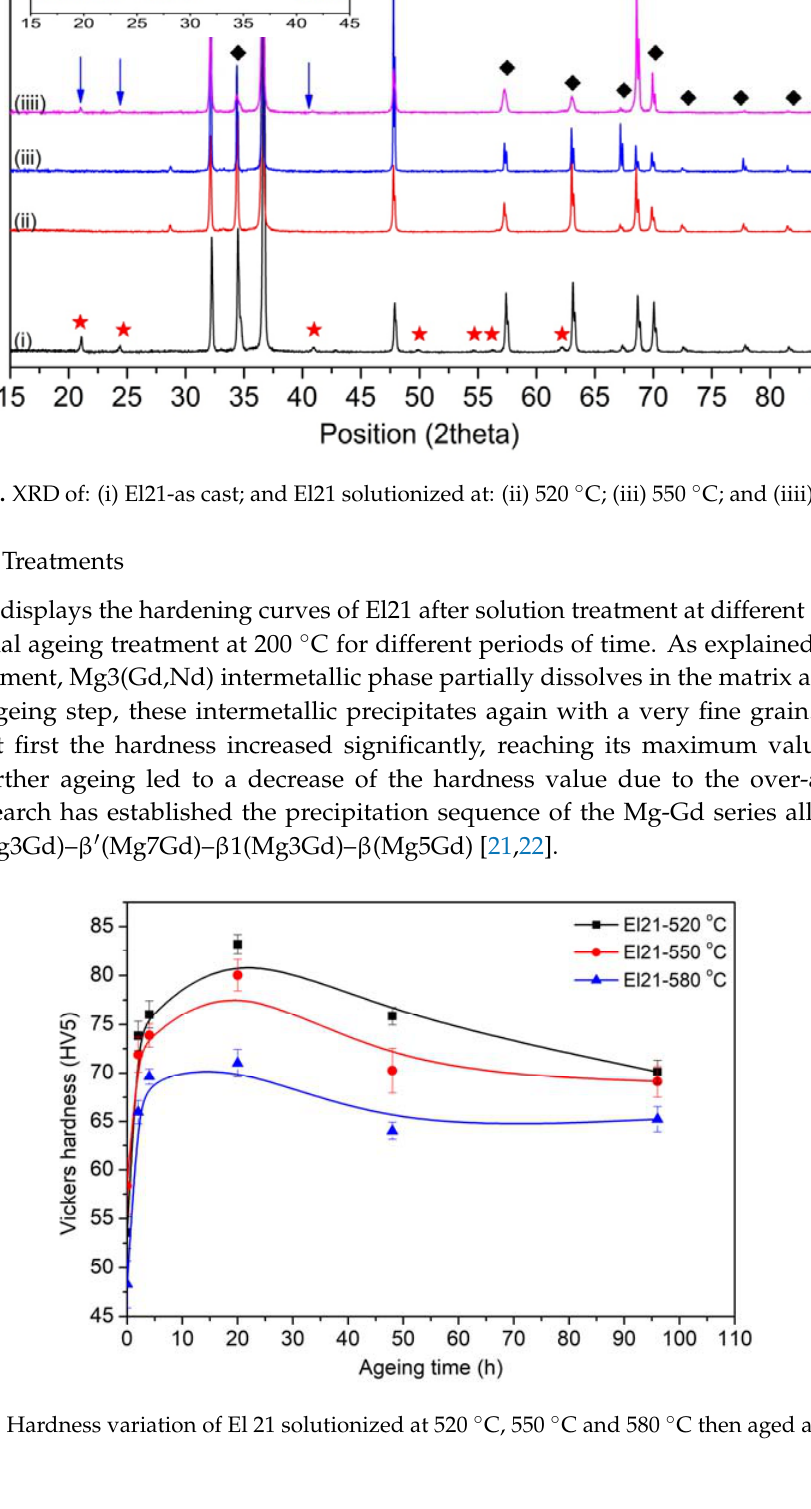
Figure 8. XRD spectra of EL21: ( a ) after solutionizing at 580 °C; and ( b ) solutionizing at 580 °C followed by ageing at 200 °C for 96 h. 3.2. Elektron21–AlN Composites 3.2.1. As cast El21–AlN Composites Figure 9 shows the microstructure of as ‐ cast El21–1.0 wt.% AlN (Figure 9a,b) and as cast El21– 2.0 wt.% AlN (Figure 9c,d). As can be seen in both cases, similar to the base alloy, the microstructure is the combination of magnesium matrix dendrites separated by interdendritic regions. Moreover, even if the dispersion of AlN within the Mg matrix seems to be rather uniform, some big AlN clusters are visible in both nanocomposites with different AlN content. (a) (b)